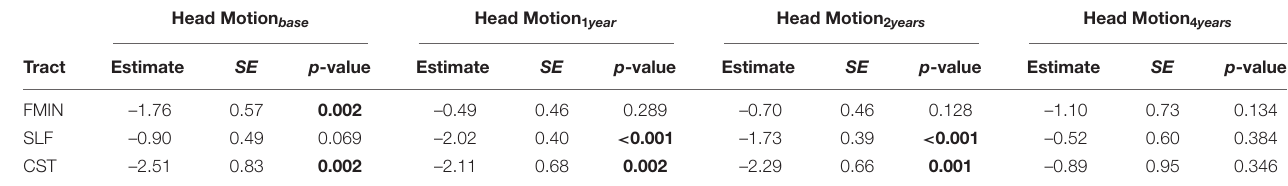
TABLE 5 | Effects of head motion on FA at each measurement occasion of best fitting univariate LGC models for WM FA.